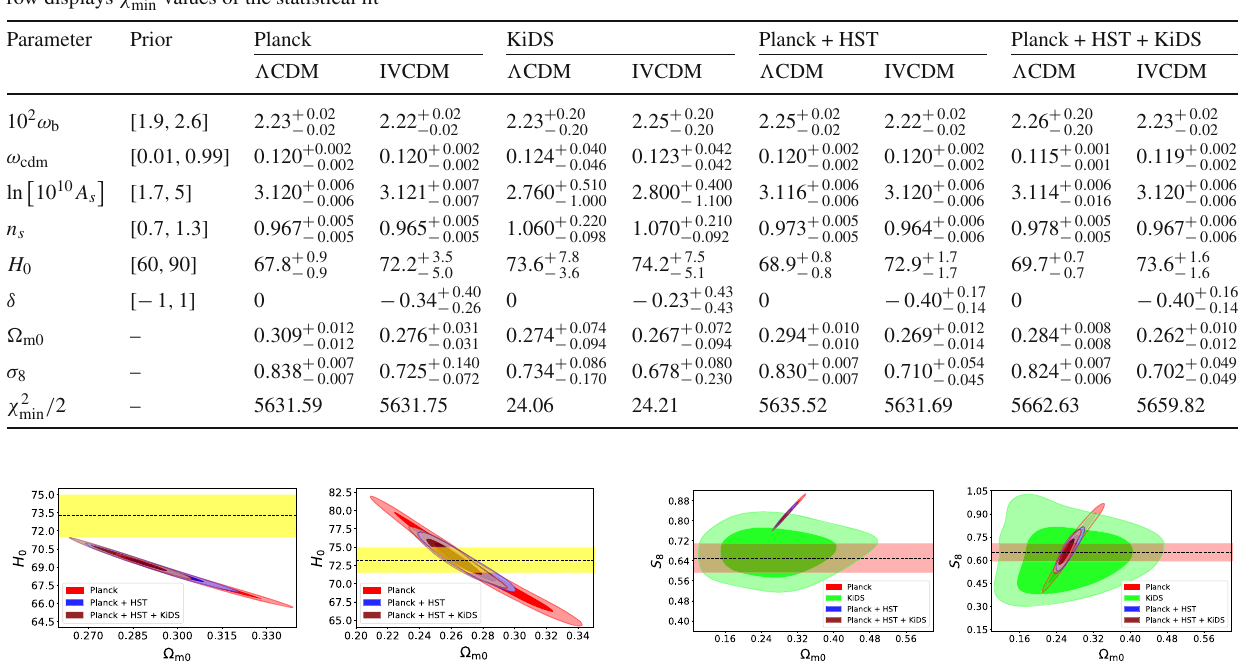
Fig. 1 Parametric space (68% and 95% CL) in the plane (cid:11) m0 − H 0 for the (cid:3) CDM (left panel) and IVCDM model (right panel) from three data sets. In the left panel, it is clear to see that the local measurement of H 0 = 73 . 24 ± 1 . 74 km s − 1 Mpc − 1 [4] (yellow band) is in disagreement with the statistical region of H 0 from the three data sets within the (cid:3) CDM cosmology. In the right panel, we see that there is no tension on H 0 within 68% CL in the IVCDM model